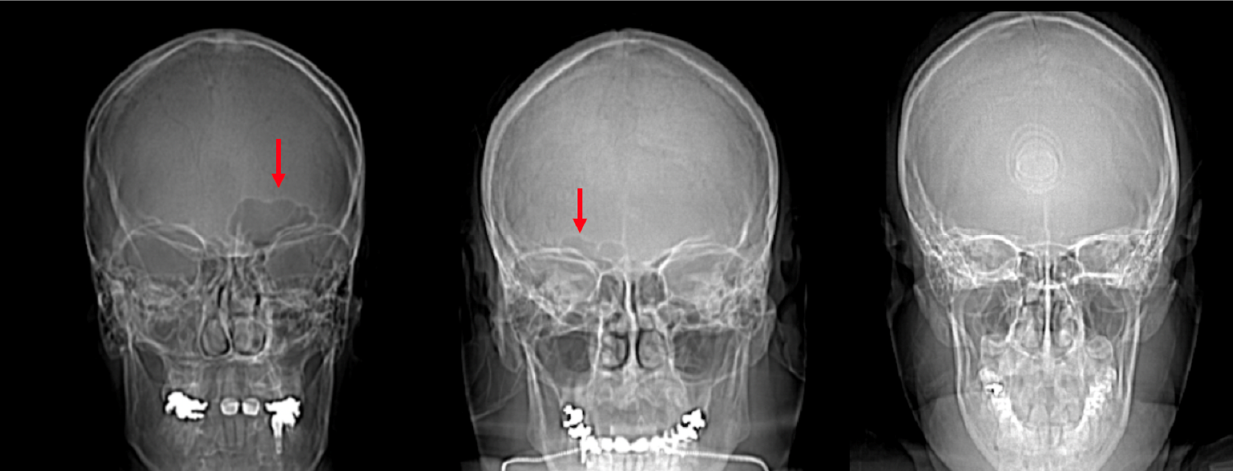
Figure 6. Scout images of the crania of individuals with a unilateral left frontal sinus ( left , red arrow), unilateral right frontal sinus ( center , red arrow), and bilateral absence of a frontal sinus ( right ).